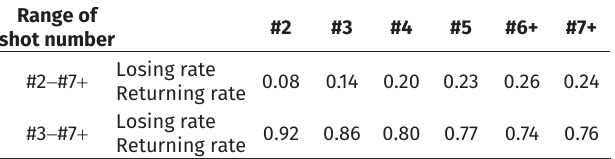
Table 2. A sample of the losing rate and returning rate expected from the specific ranges of shot numbers. For instance, ‘#2–#7+’ denotes that the losing rate and returning rate were calculated from the second shot and